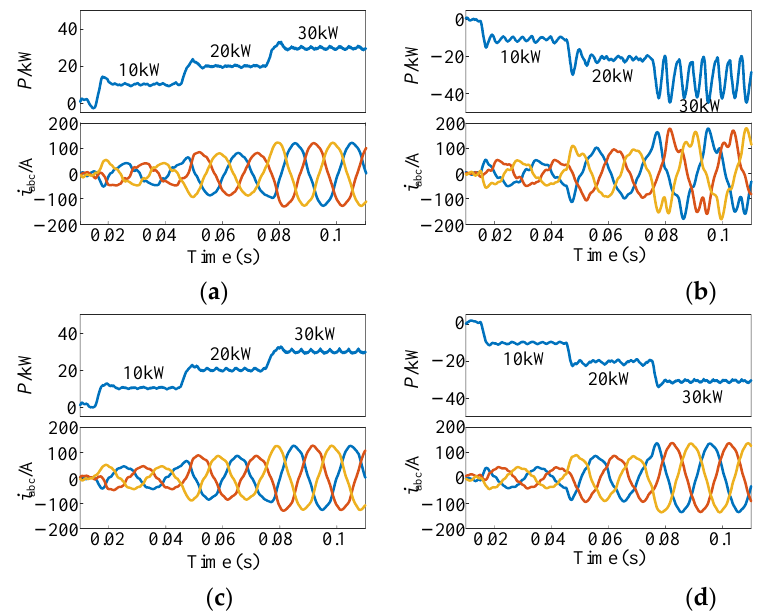
Figure 17. Simulation results at the high-power level as P changes, with U d = 155 V. ( a ) Conventional control under forward power flow. ( b ) Conventional control under reverse power flow. ( c ) IRSE control under forward power flow. ( d ) IRSE control under reverse power flow.